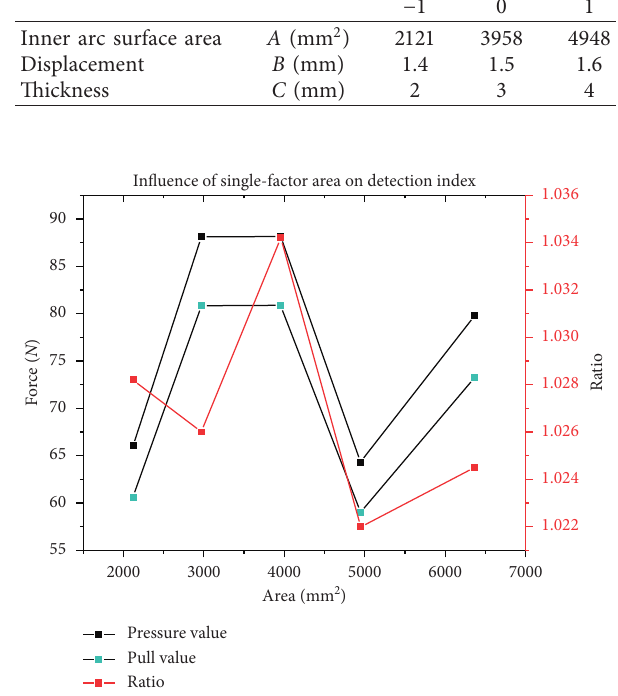
Figure 6: Impact of different areas on the detection